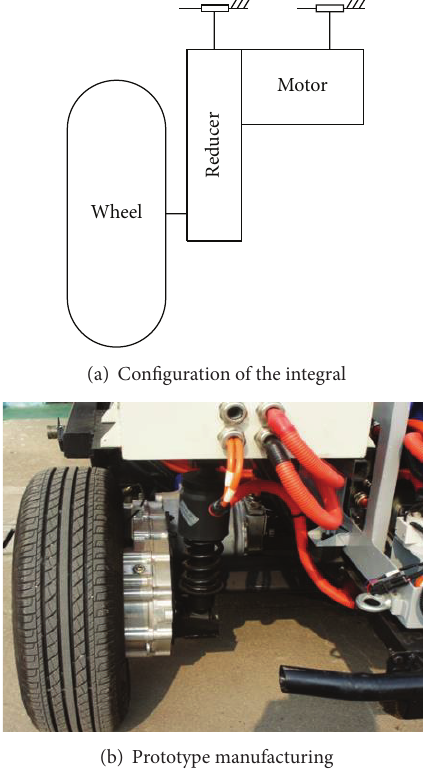
Figure 2: Integral of electric drive and single trailing arm suspen-